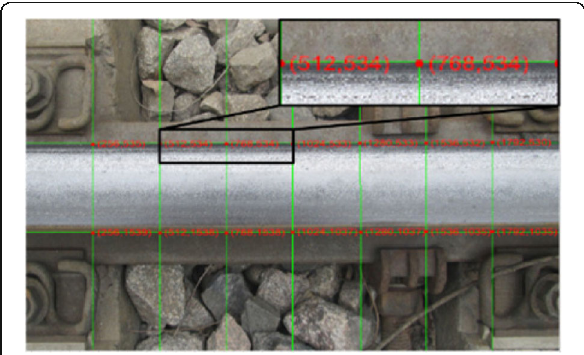
Fig. 4 Sketch of boundary fitting results